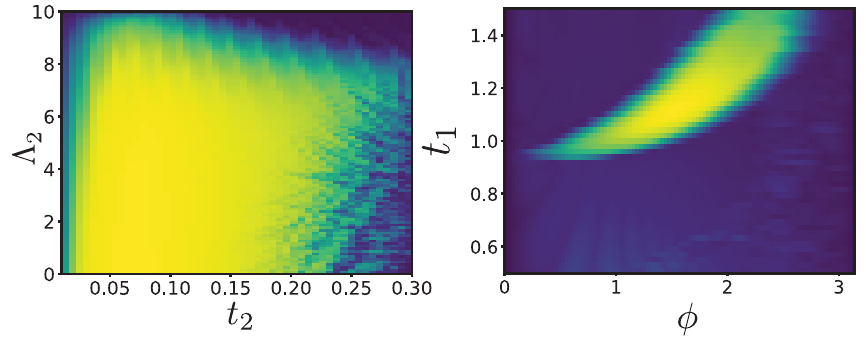
Figure 3: In this figure we demonstrate the stability of the n = 2 stroboscopic aliasing subharmonic oscillations to variation of hamiltonian parameters. The two panels are for α = 0 and are computed using exact quantum dynamics. They show the order ( f ) discussed in the text as a function of Λ J parameter max f y initial phase φ (right). In these plots, the brightest yellow corresponds to J ( f ) = while the darkest blue to J y